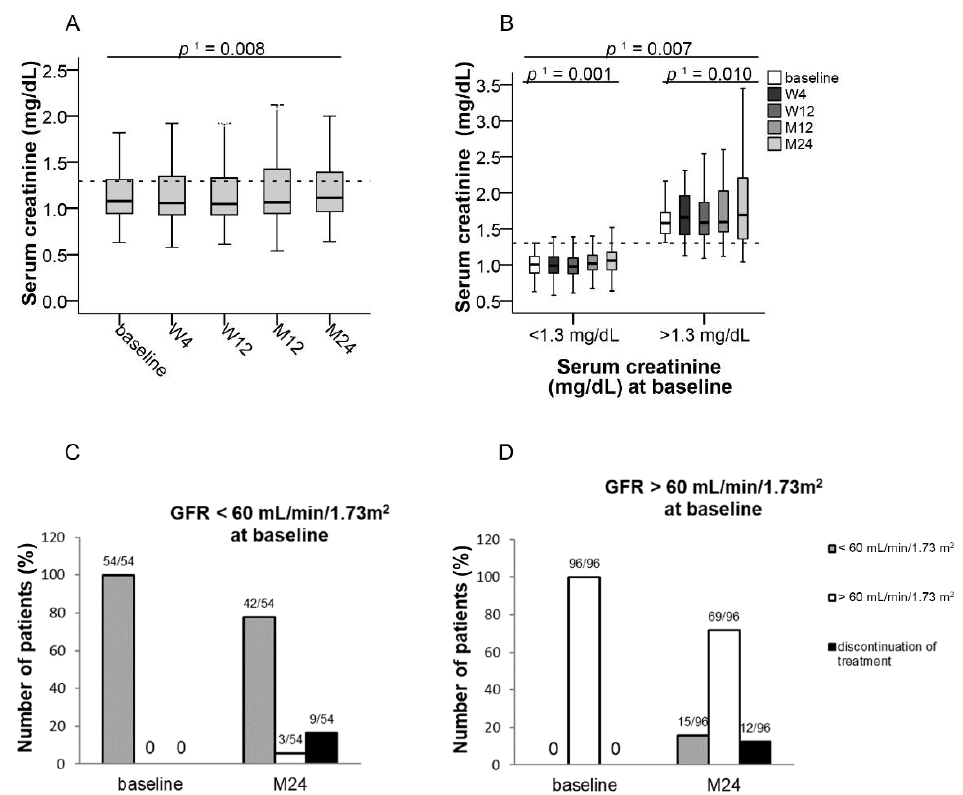
Figure 3. Median serum creatinine and GFR after switching to LCPT at the baseline visit as well as at weeks 4 and 12 and at months 12 and 24. Boxplots show median values with 95% CI ( A ) for serum creatinine and ( B ) for serum creatinine according to normal or increased values at baseline; ( C , D ) show the number of patients for GFR categories < or > 60 mL/min/1.73 m 2 at baseline and at 24 months who initially ( C ) had a GFR < 60 mL/min/1.73 m 2 or ( D ) had a GFR > 60 mL/min/1.73 m 2 ; 1 with Greenhouse–Geisser correction; GFR: glomerular filtration rate, LCPT: once-daily MeltDose ® prolonged-release tacrolimus, M: month, W: week.